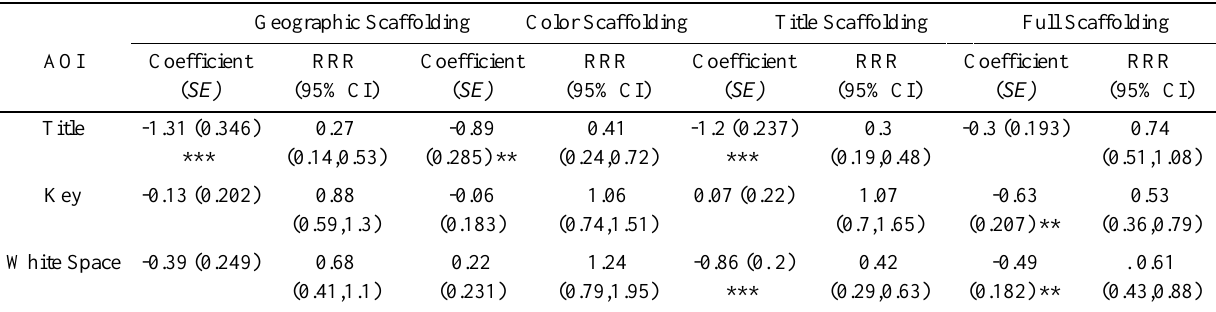
Relative Risk Ratios for Areas of Interest with Expertise as Main Effect, Unscaffolded versus Scaffolded Cases, All Subjects (N = 16), MI. Geographic Scaffolding Color